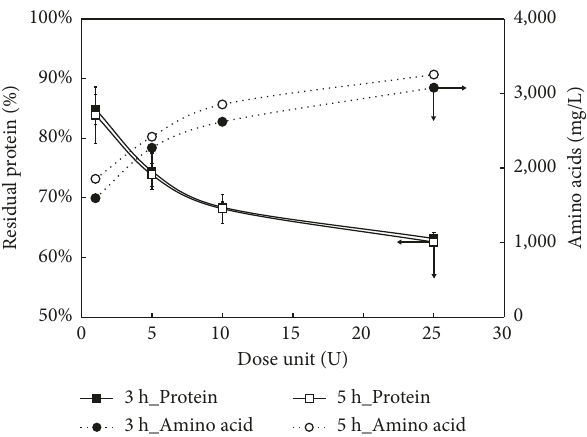
Figure 2: Effect of substrate (fibroin):enzyme ratio on the proteolytic activity of FoodPro in 0.25M citrate-phosphate buffer.